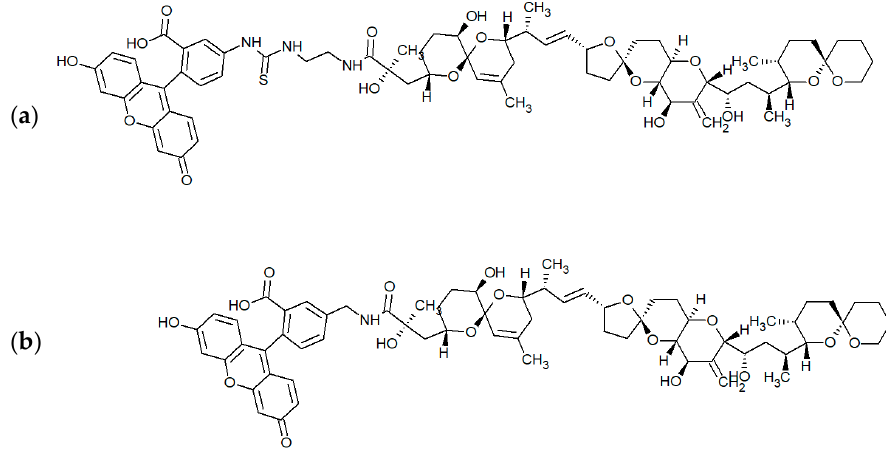
Figure 2. Structures of OA–EDF ( a ) and OA–AMF ( b ) tracers.